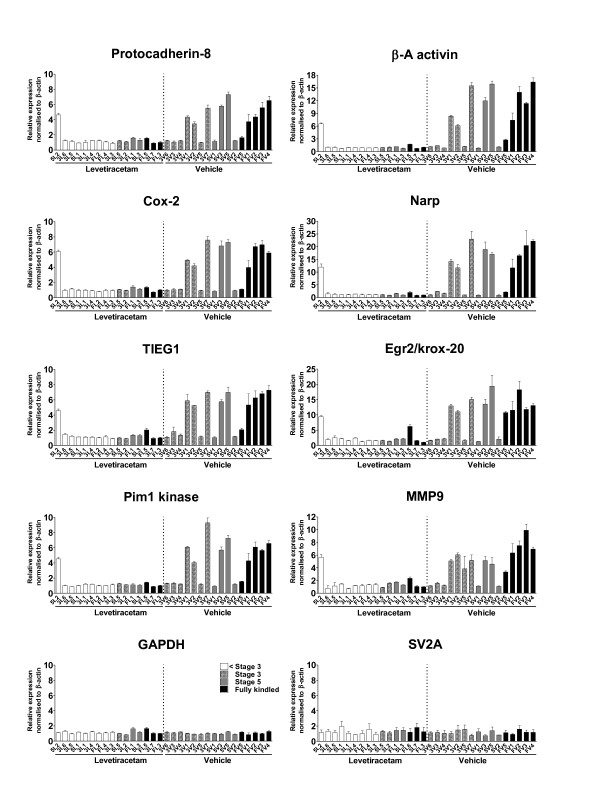
Single animal profiling the effects of levetiracetam on kindling-induced genes in amygdala-kindled rats. Quantitative RT-PCR of RNA from the contralateral hippocampus of levetiracetam and vehicle treated amygdala-kindled rats with primers against 8 seizure-induced genes and GAPDH and SV2A as control. Vehicle treated rats and levetiracetam treated animal pairs are numbered according to Table 1. In the vehicle and the levetiracetam groups shaded, grey and black bars represent stage 3, stage 5 and fully kindled animals, respectively. White bars represent lower than stage 3. All data are expressed relative to animal FL3, normalized to β-actin levels and expressed as mean ± SEM.